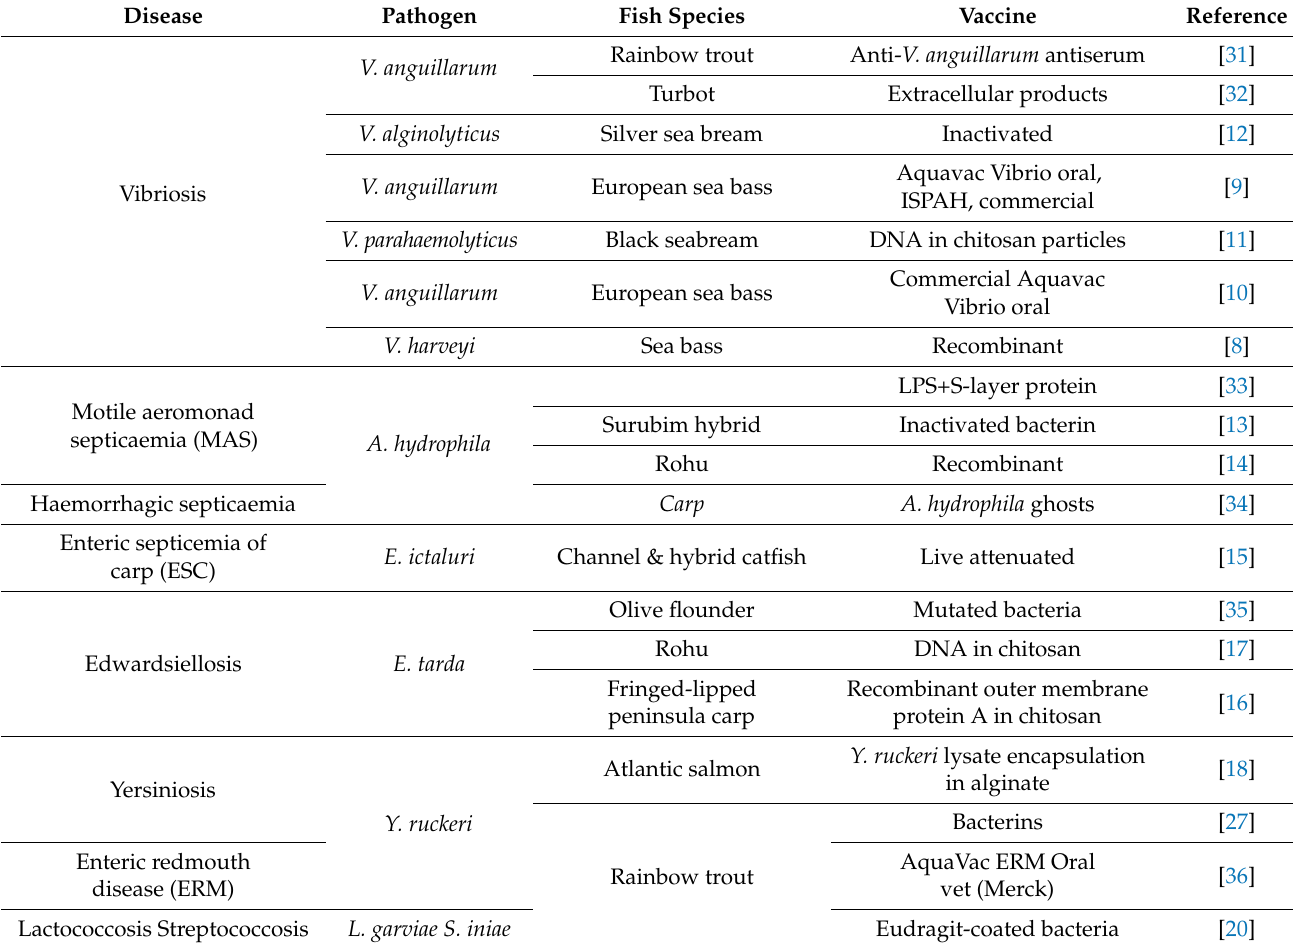
Table 1. Overview of recent oral vaccination trials against bacterial